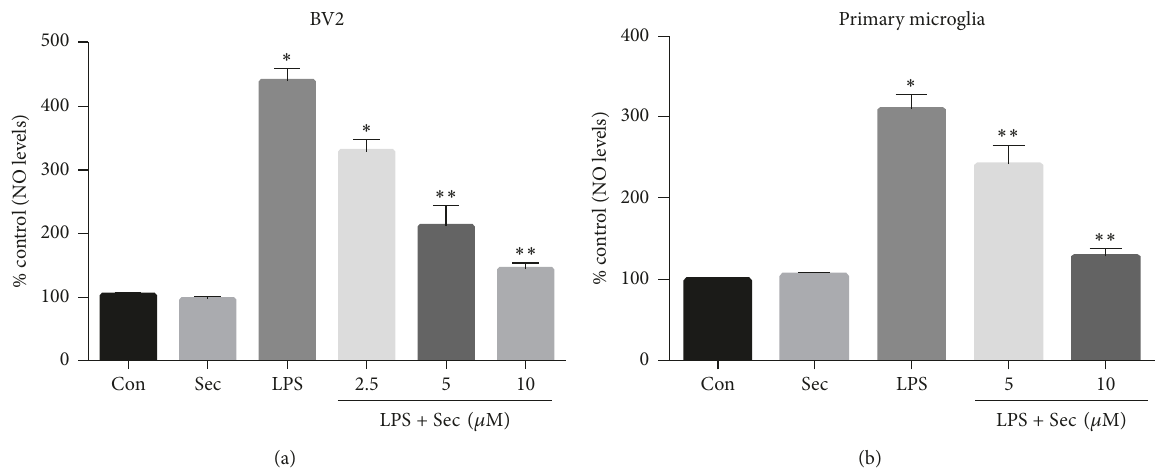
Figure2:SecurinineinhibitsLPS-inducedNOproductionintheBV2celllineandinmouseprimarymicrogliachallengedwithLPSexposure. BV2 microglial cells (a) and mouse primary microglia (b) were pretreated with securinine (2, 5, and 10 𝜇 M) for 1h and then stimulated with LPS (500ng/mL) for 24 h. NO levels in the medium were determined using the Griess Reagent system. The data are expressed as mean ± SD, 𝑛 = 4 . ∗ 𝑃 < 0.01 , significantly different from control samples. ∗∗ 𝑃 < 0.05 significantly different from the LPS-treated group